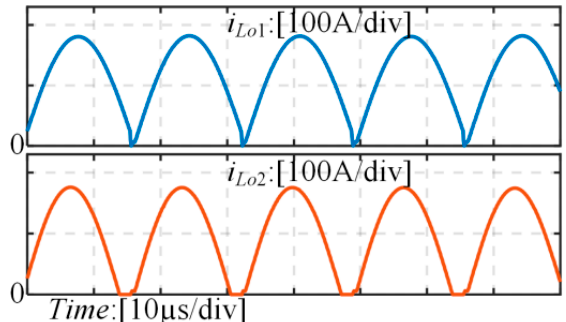
Figure 11. Steady-state output current of LLC converters.